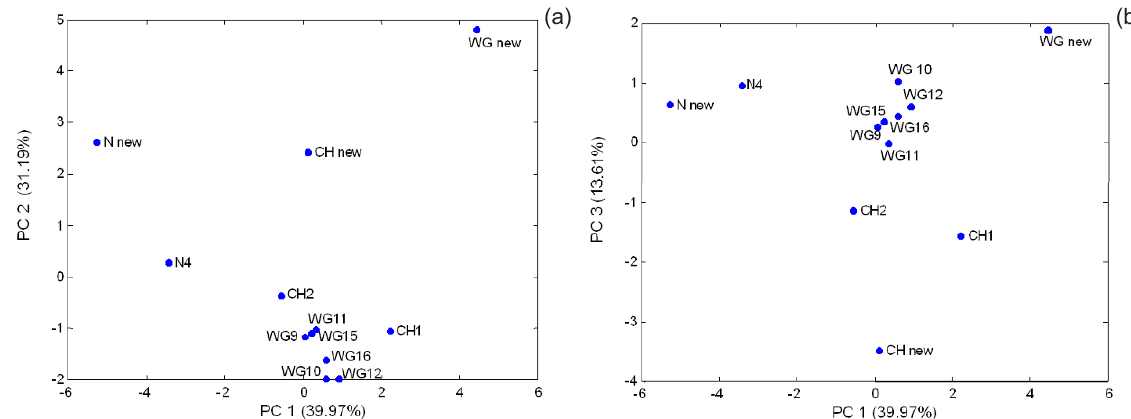
Figure 3. PCA score plots – projection of activated carbon samples on the plane spanned by: (a) PC 1 and PC 2, (b) PC 1 and PC 3. Table 7. Mann-Whitney U test and t-Student test for activated carbons Nn and N4.